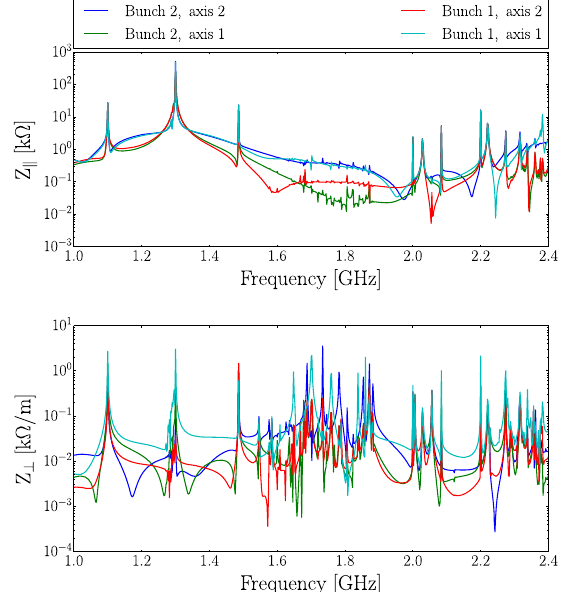
FIG. 13. The longitudinal impedance (top) and transverse impedance (bottom) spectrum.